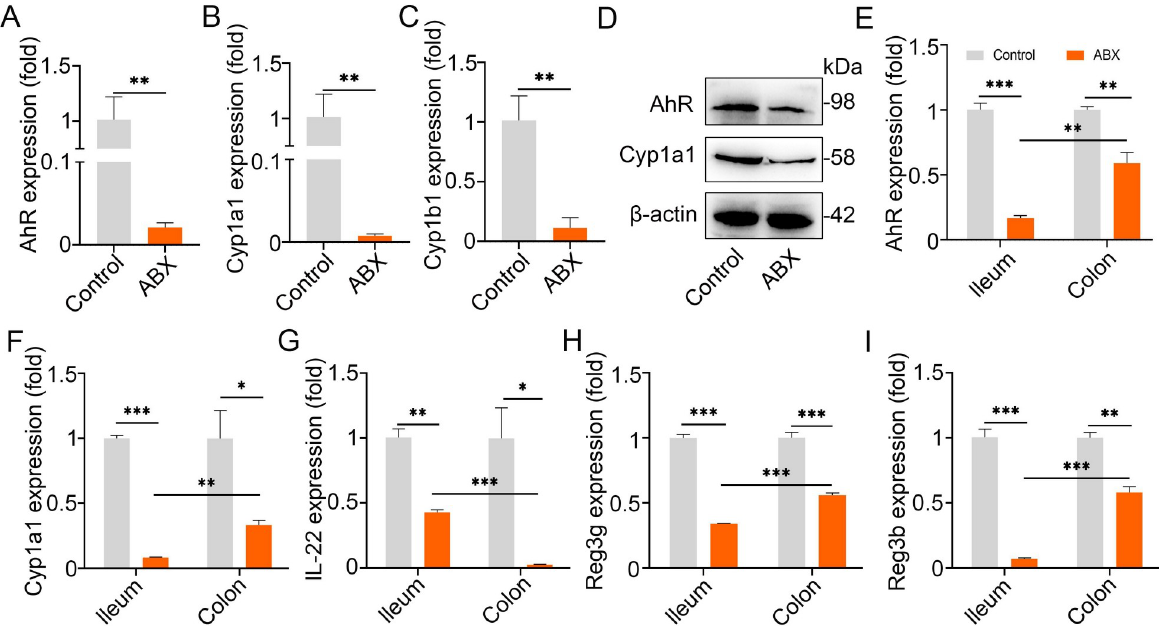
Fig 3. Gut dysbiosis impairs AhR activation. The mice were treated with a cocktail of antibiotics (ABX) containing 1 g/L ampicillin, neomycin sulfate and metronidazole and 0.5 g/L vancomycin for three weeks. Then, the mammary gland, ileum and colon tissues were collected. ( A-C ) The AhR, Cyp1a1 and Cyp1b1 mRNA levels in the mammary glands were identified using qPCR (n = 3). ( D) Protein expression of AhR and Cyp1a1 in mammary glands of control and ABX-treated mice (n = 3). The levels of AhR ( E ), Cyp1a1 ( F ), IL-22 ( G ), Reg3g ( H ) and Reg3 β ( I ) mRNA in ileum and colon tissues from control and ABX-treated mice were measured by qPCR (n = 3). Student’s t test were applied for statistical analysis in ( A-C) and ( E-I) and the date are shown as means ± SEM. � p < 0.05, �� p < 0.01 and ��� p < 0.001 indicate significant differences from each group. ABX, a cocktail of